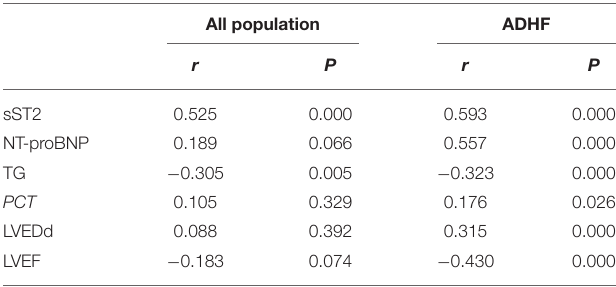
TABLE 2 | Correlation between the β 1-AA and indexes by Pearson correlation analysis in all population and patients with ADHF. All population ADHF r P r